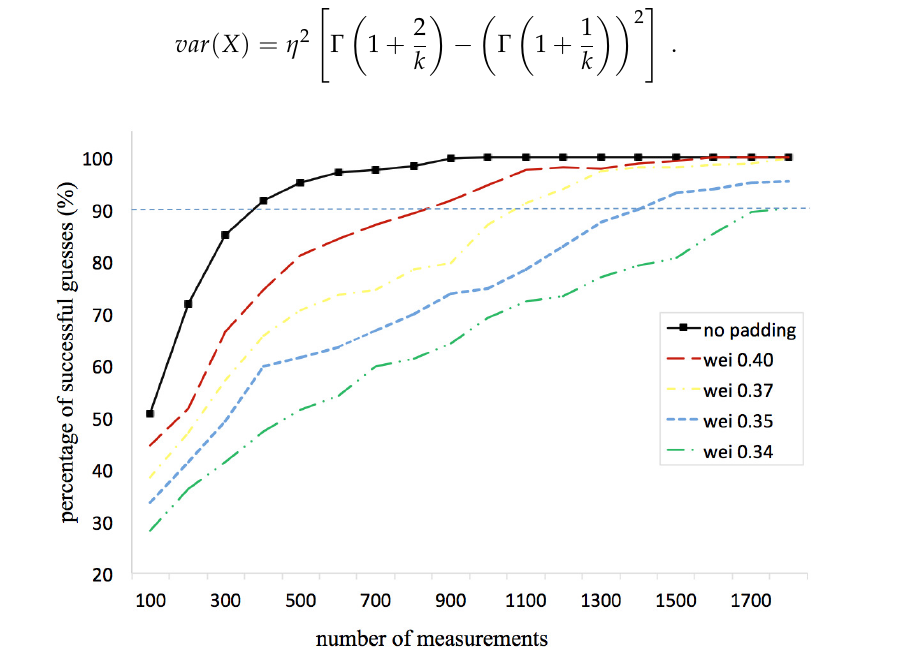
Figure 4. The mitigation effectiveness of different random delay paddings. Table 2. Optimum rekeying rate for the WSN with different parameter sets of the Weibull distribution. Shape Para Scale